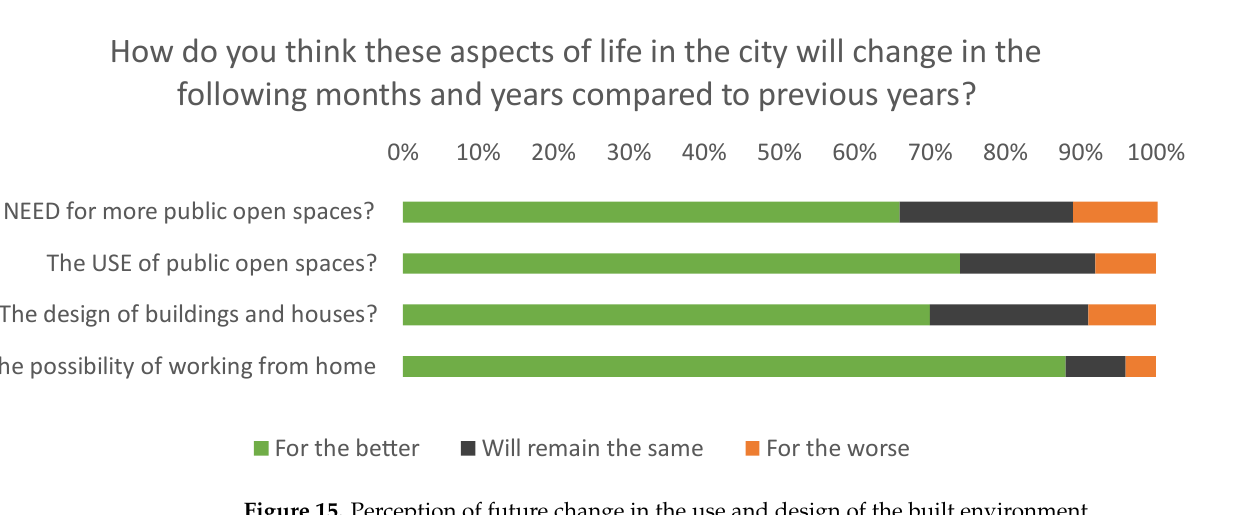
Figure 15. Perception of future change in the use and design of the built environment. Table 6. Summary of identified opportunities to enable a RC4BE. General